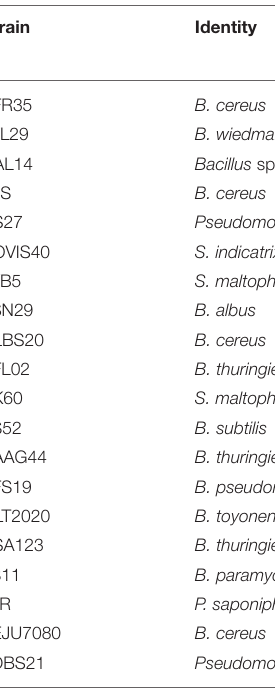
TABLE 2 | Identification of endophytic bacteria based on 16S rRNA gene sequences. Strain Identity % Similarity GBAN Homologous